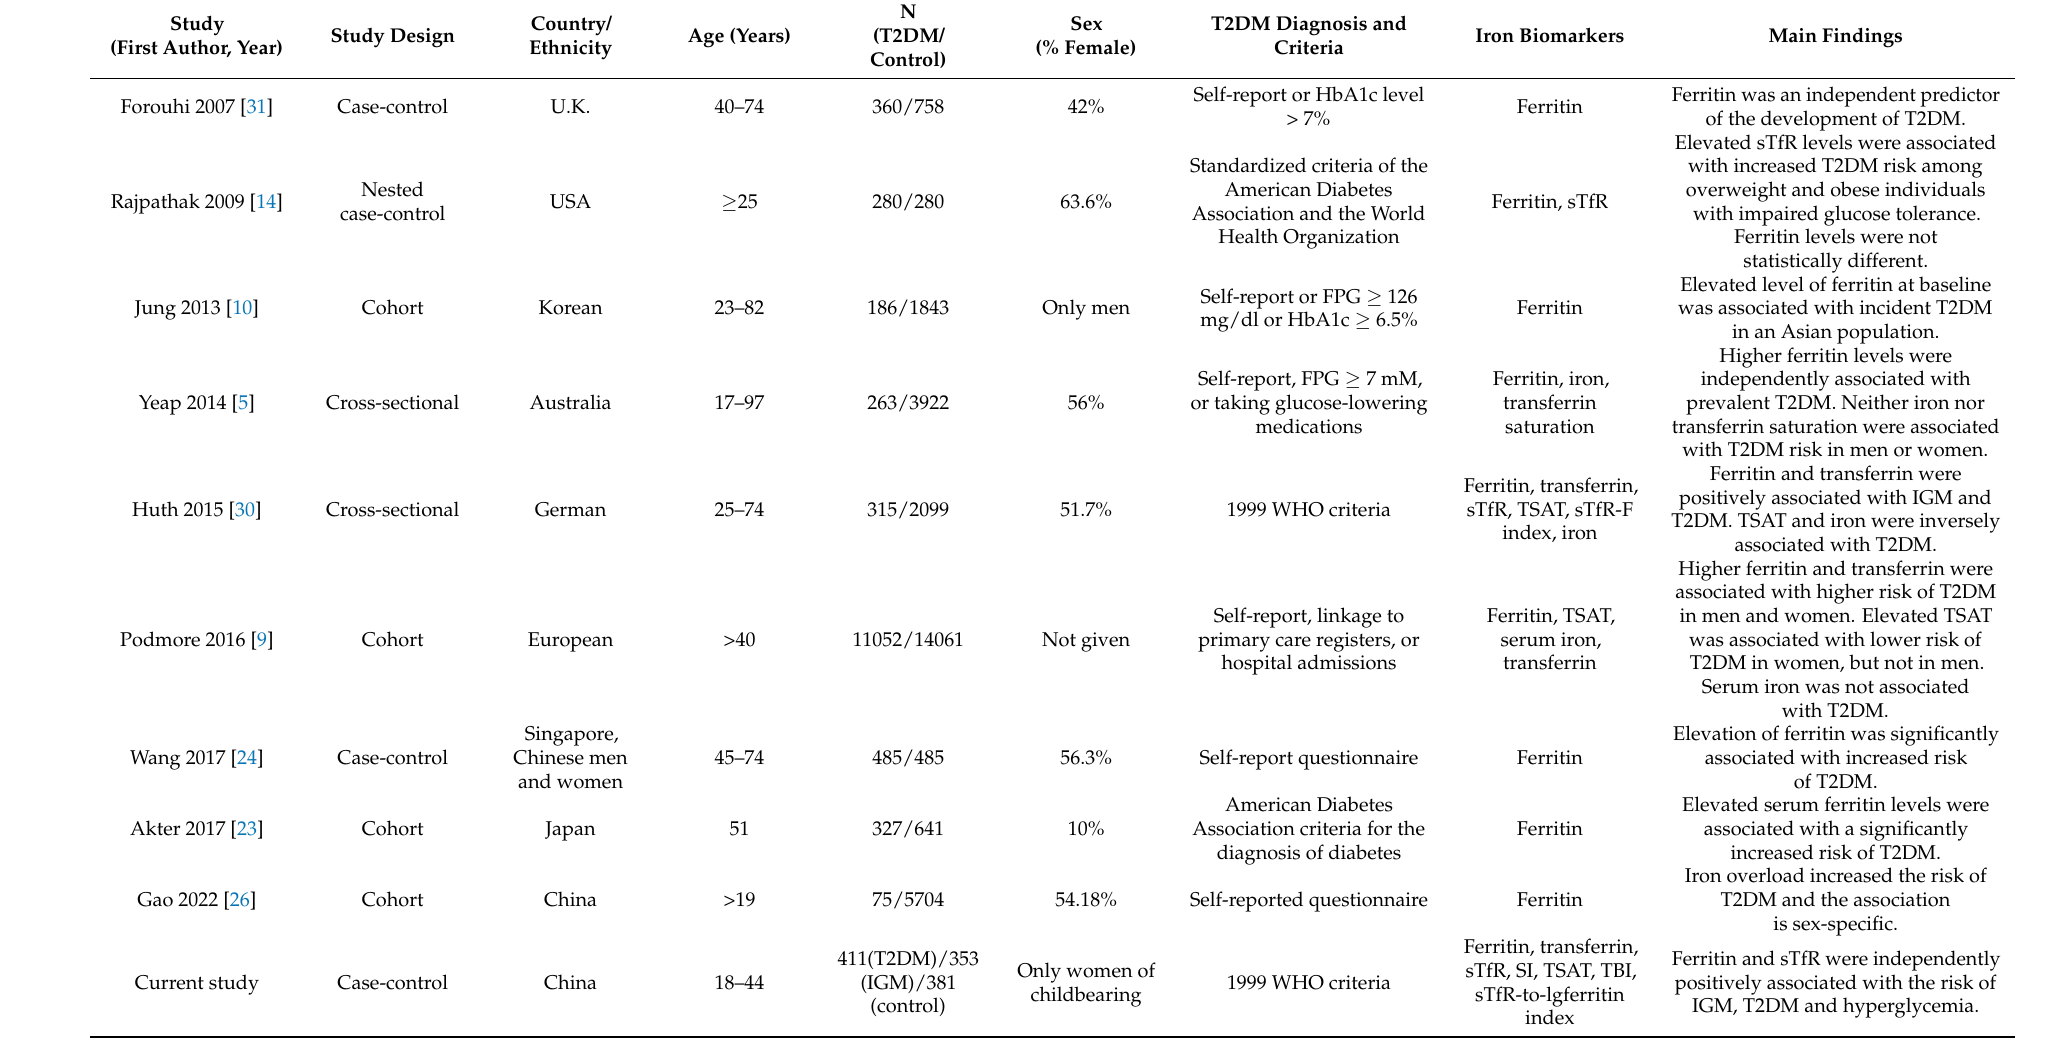
Table 5. Characteristics of study on the association between iron metabolism and T2DM